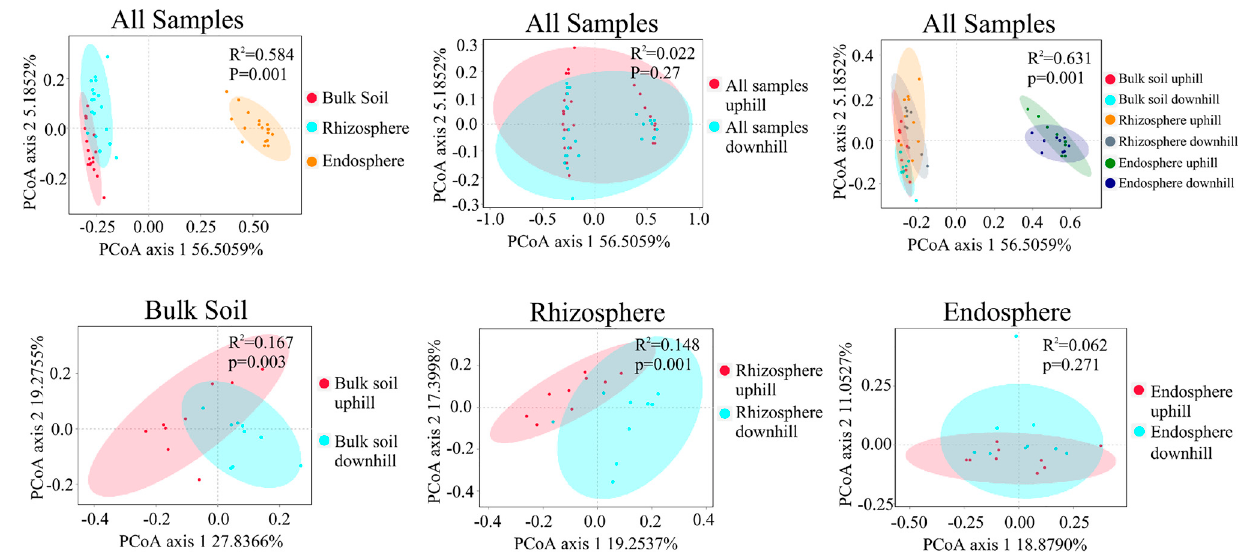
Figure 1. PCoA plot showing the variations in bacterial communities based on the Bray–Curtis distance (PERMANOVA was used to test for significant differences). Ellipses indicate 95% confidence intervals for each sample type.